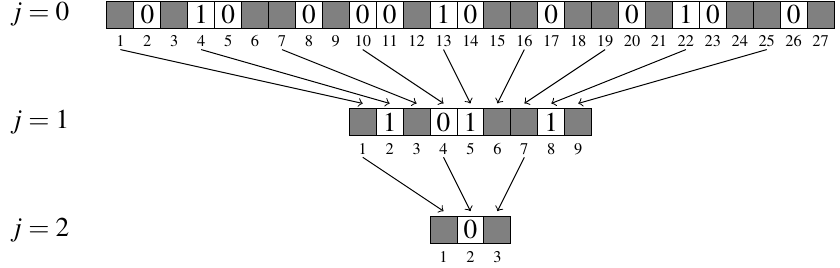
Figure 1: The procedure applied to a word w ( s ) of length 27 = 3 2 + 1 . In this case, the word is not rejected and u ( s ) = 010 is